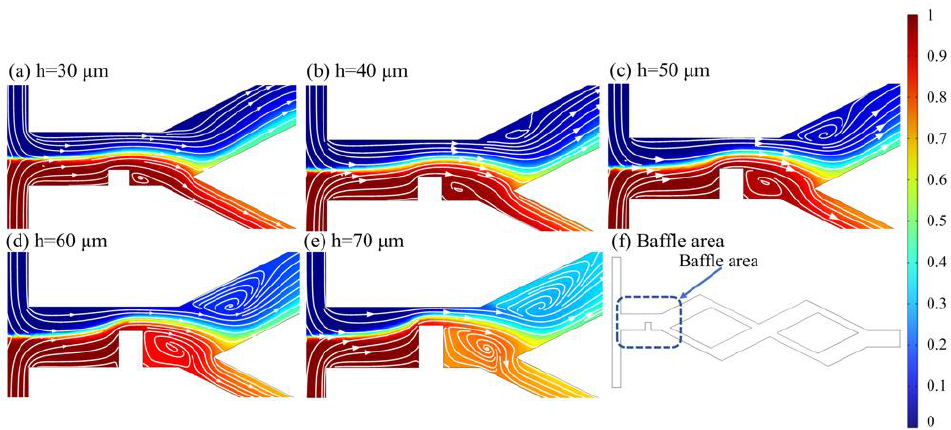
Figure 19. Concentration distribution and velocity streamline at the baffle area at Re = 60. ( a ) h = 30 µ m; ( b ) h = 40 µ m; ( c ) h = 50 µ m; ( d ) h = 60 µ m; ( e ) h = 70 µ m; ( f ) Baffle area